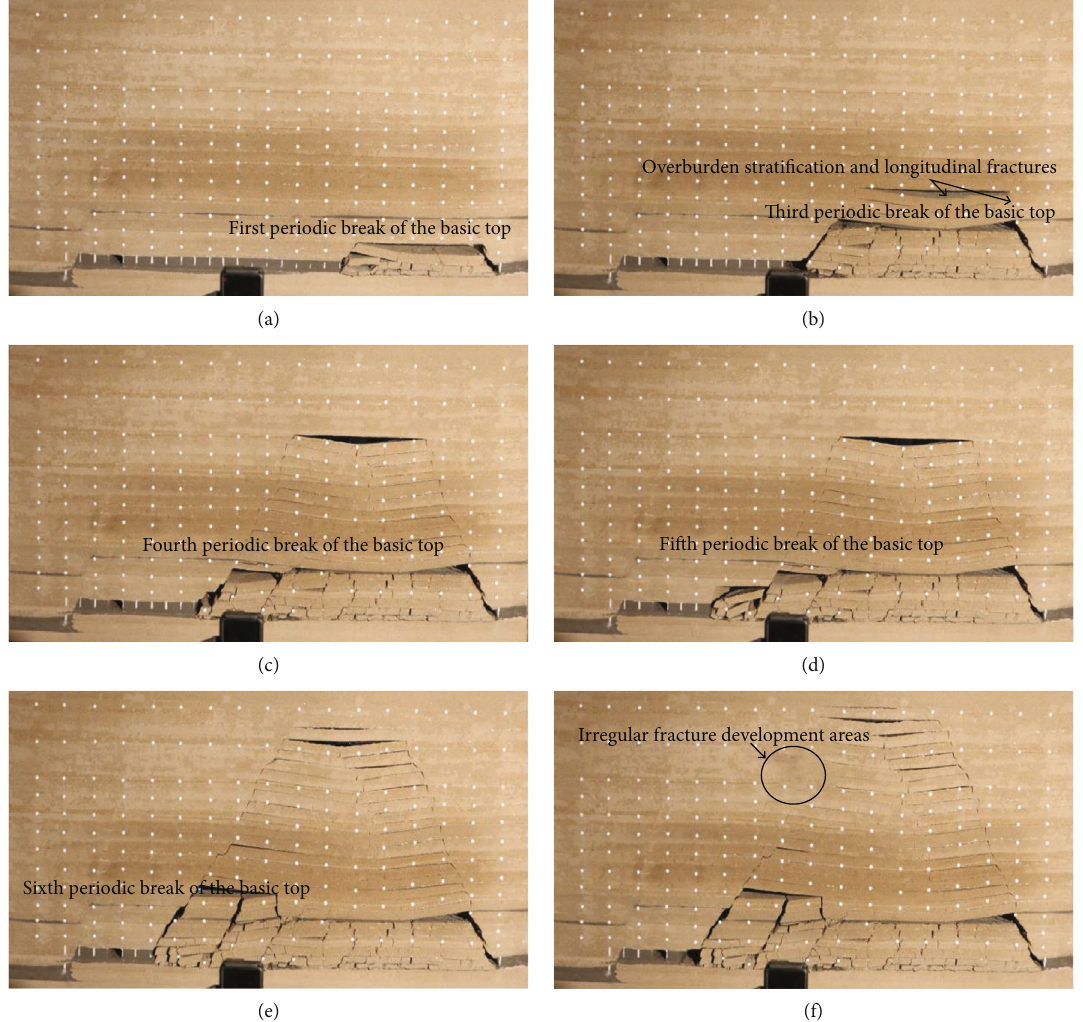
Figure 9: Periodic fracture diagram of basic roof under di ff erent distances of working face advancing, including (a) 105 m, (b) 145 m, (c) 175m, (d) 185m, (e) 195 m, and (f) 205 m.